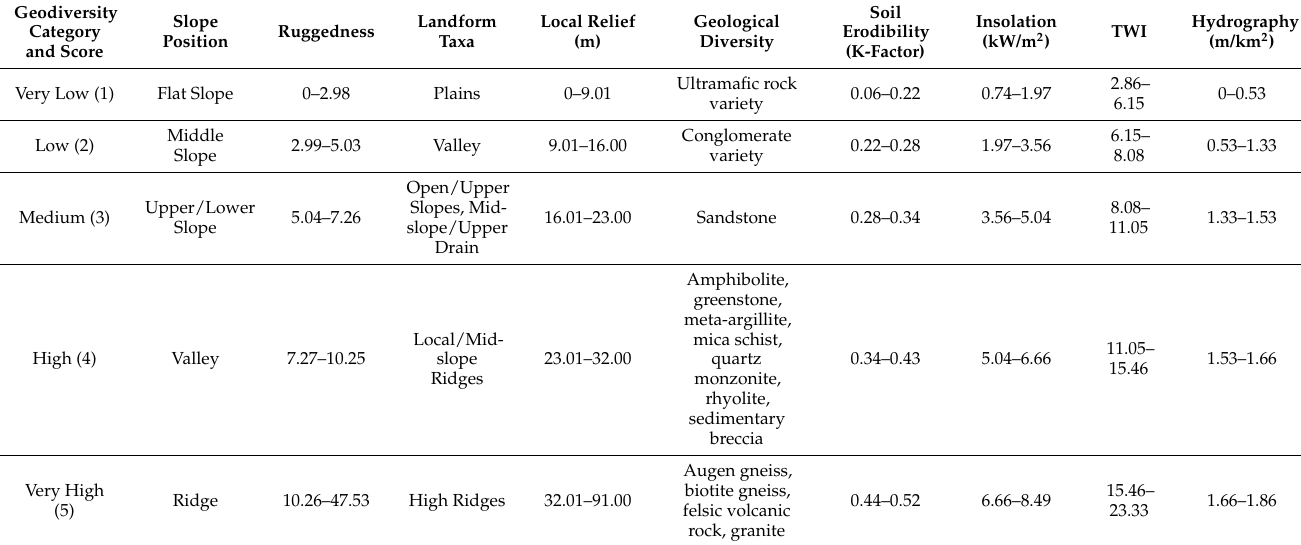
Table 1. Values of the ten factors used in the geodiversity